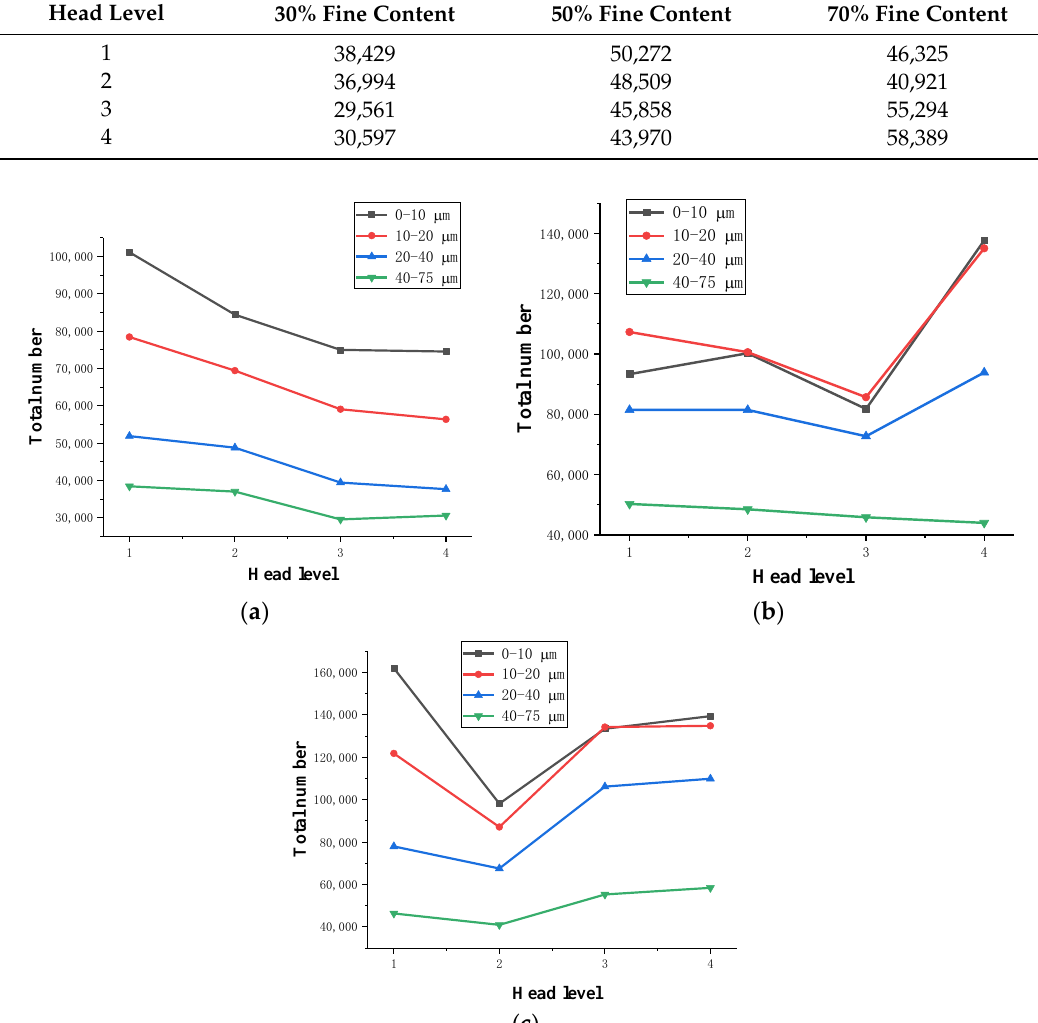
Figure 17. The number of fine particles with different particle sizes. ( a ) 30% fine content; ( b ) 50% fine content; ( c ) 70% fine content.